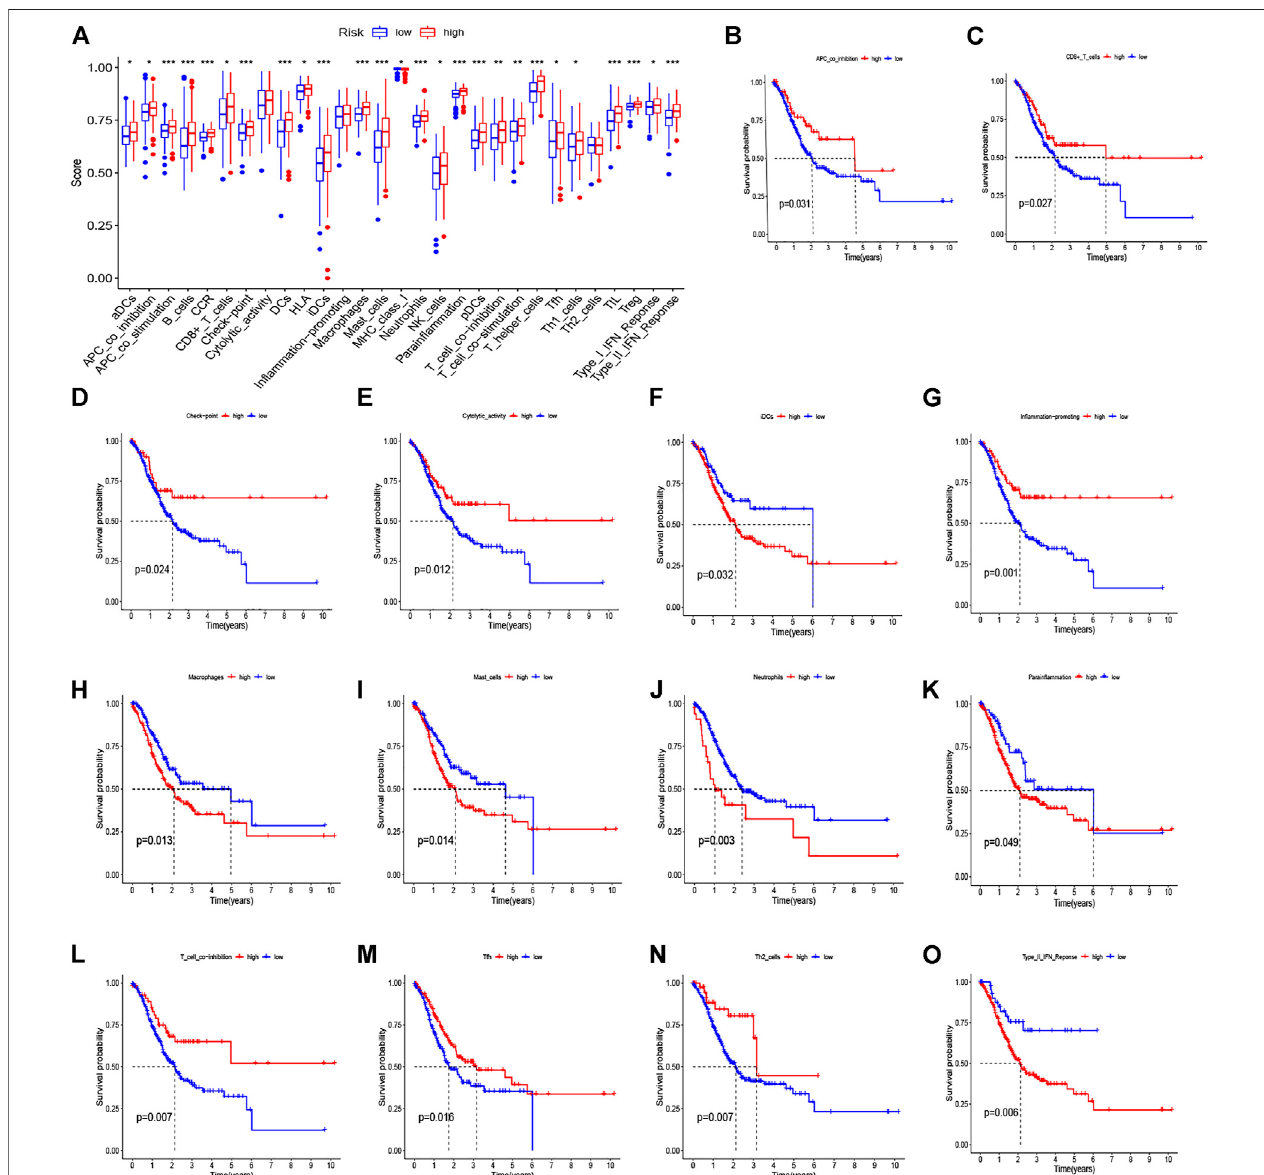
FIGURE 9 | Immune function – related analyses between high- and low-risk groups. (A) The boxplot for 29 immune functions in high- and low-risk groups. (B – O) Kaplan – Meier curve for survival in high- and low-in fi ltration groups based on 14 signi fi cant immune functions.